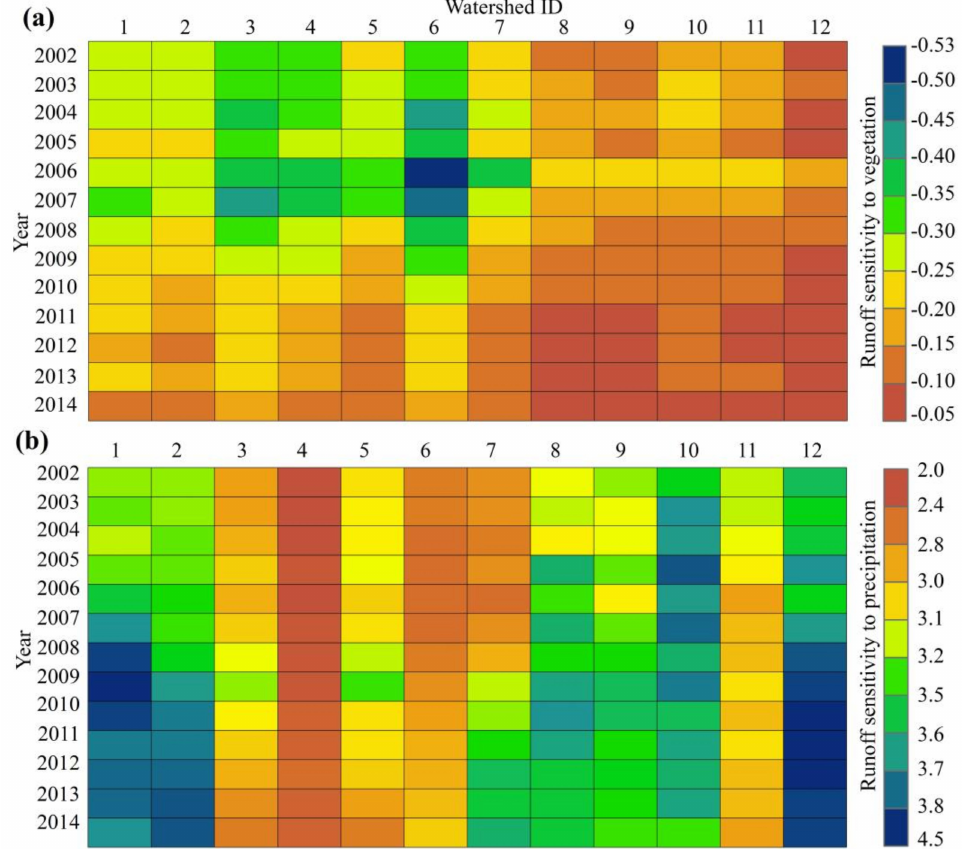
Figure 8. Runo ff sensitivity to ( a ) regreening ( f PAR) and ( b ) precipitation for the 12 watersheds during